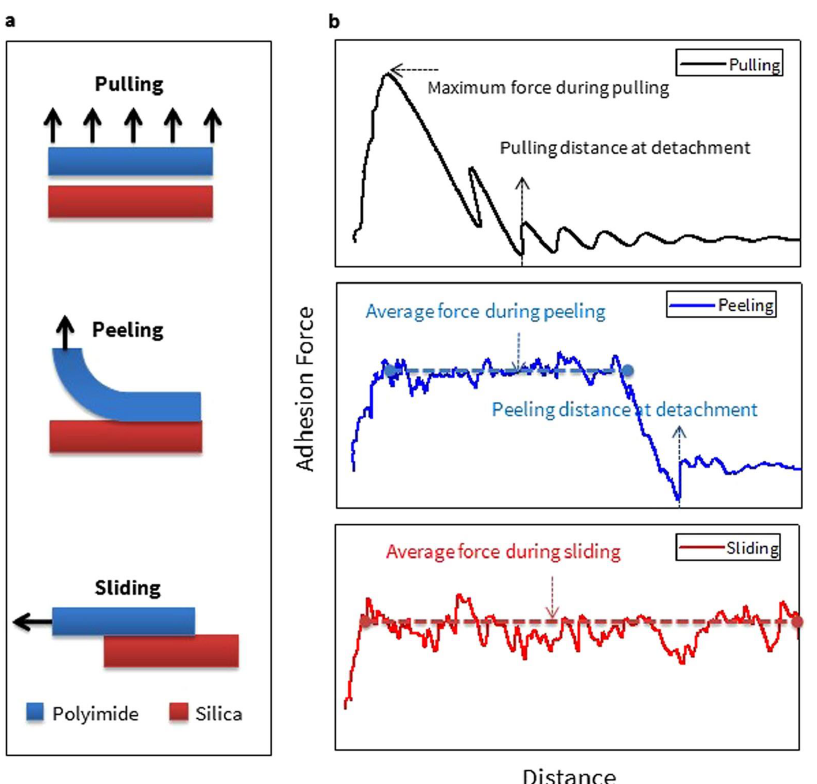
Figure 1. ( a ) The schematic view and ( b ) representative properties for characterizing the adhesion properties from each of adhesion testing modes (adapted with permission from Reference [27], Copyright 2017 Springer Nature).